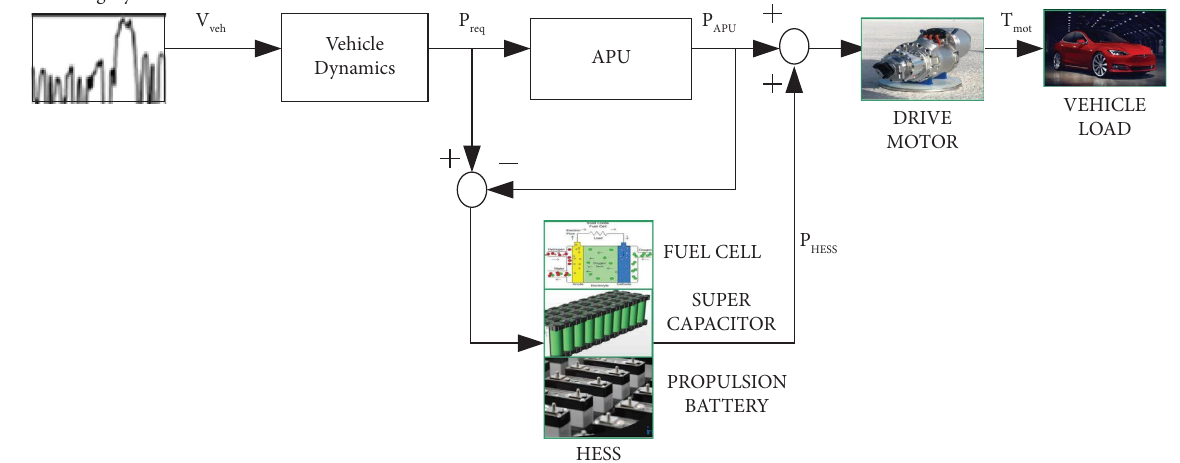
Figure 12: General diagram of a power fow